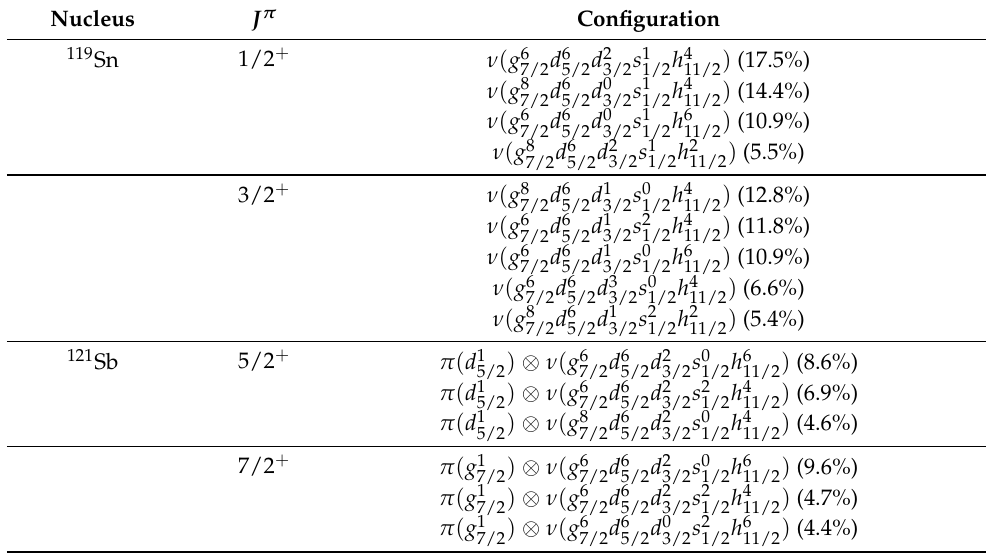
Figure 1. Comparison of experimental and calculated states: ( a ) left panel is for 119 Sn, with experi- mental values from Ref. [44], and ( b ) right panel is for 121 Sb, with experimental values from Ref. [45]. Ground state and first excited state are flipped for 121 Sb. Table 2. The configurations of the lowest-lying states of 119 Sn and 121